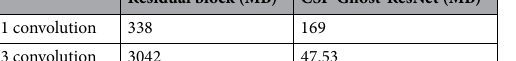
Residual block (MB) CSP-Ghost-ResNet